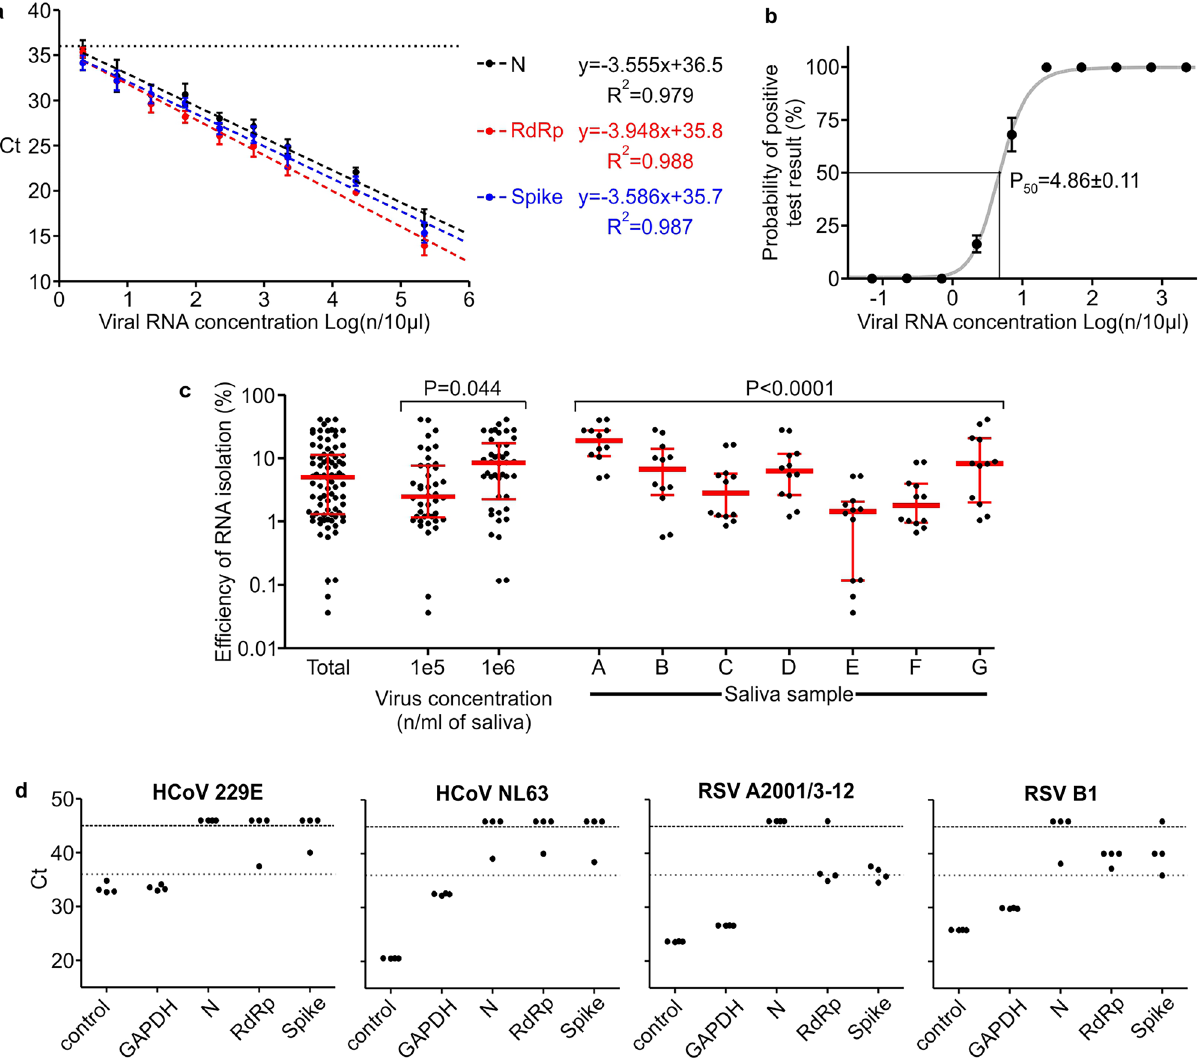
Figure 3. Quantitative performance of the screening test. ( a ) RNA-based Ct calibration curves for individual genes. Mean ± SD, n = 6. Dashed lines: linear regression curves fitted to data. The calculated curve equations and coefficients of determination are listed on the right side. Linear fitting P < 0.0001 for each gene. Dotted horizontal line: threshold Ct value for specific amplification. ( b ) Probability of obtaining positive results of the screening test depending on viral RNA concentration in a sample. Black points/whiskers: 95% confidence intervals with the center of each interval marked. Gray line: four parameter logistic curve fitted to data. P 50 value presented as the mean ± SEM. ( c ) Efficiency of RNA isolation: number of copies calculated from Ct calibration curve divided by number of viral particles added to saliva samples. Each point represents efficiency calculated independently from a single viral gene replicate. Red lines/whiskers: median and interquartile range. Data points presented as total are also analyzed by groups, depending on virus concentration or saliva sample used as a carrier for isolation. The significance of differences between groups was calculated with ANOVA. No post hoc tests were performed. ( d ) Experimental verification of cross-reactivity with selected respiratory viruses. Ct values for individual genes obtained by qPCR in a seminested screening test using RNA samples of chosen non- SARS-CoV-2 respiratory viruses; control: primer pair specific to each virus. Upper dashed line: last cycle of the reaction; points above indicate samples with no detectable amplification. Lower dotted line: chosen threshold for specific amplification; points above are considered nonspecific by which, probably due to inefficiency of RNA isolation or too high of an inhibitor load in a sample, the result of the test is questionable. Based on the results collected during the preparation of calibration curves, the probability of obtaining a posi- tive result of the screening test, depending on the viral RNA concentration in the tested sample, was estimated. A logistic curve was fitted to the calculated probability values (Fig. 3b); the P 50 value was reached at a concentration of 4.86 ± 0.11 genome copies per 10 µl of RNA sample (mean ± SEM), and the P 95 value was 18.8 ± 0.75.